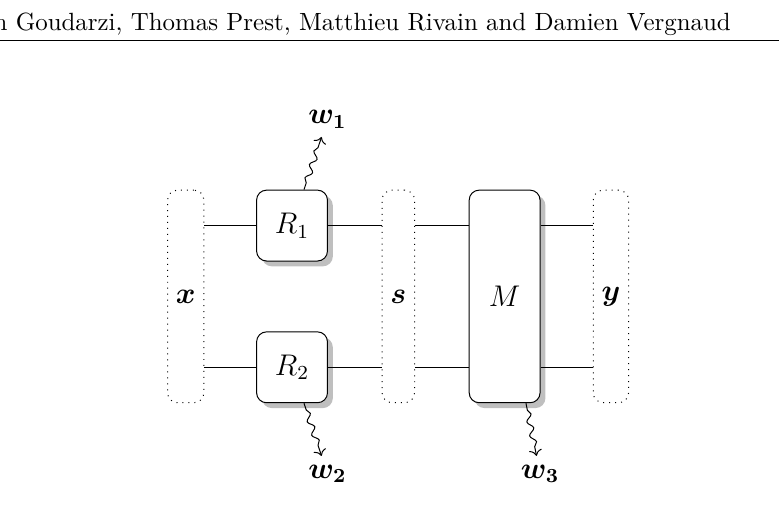
Figure 2: IOS refresh gadget with pobes ( w 1 , w 2 , w 3